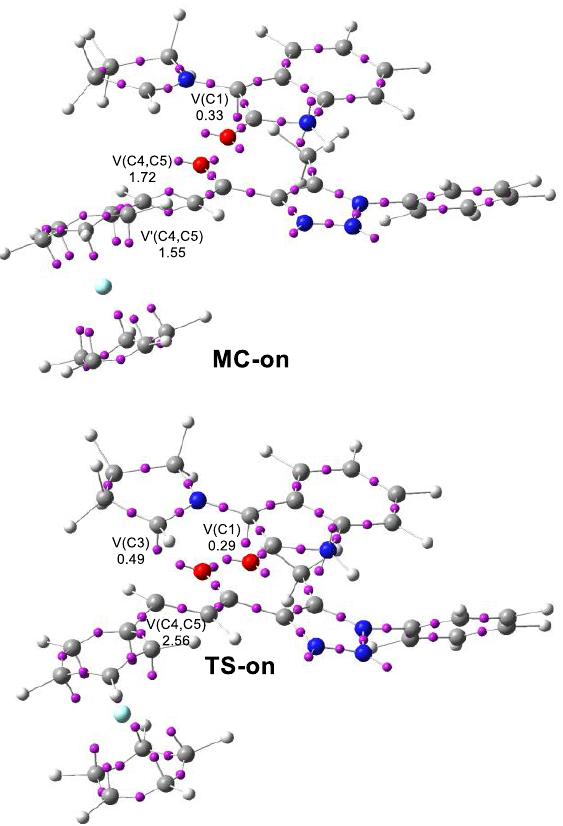
Figure 6. ω B97X-D/6-311G(d,p) ELF basin attractor positions together with the populations of the most relevant valence basins of MC-on and TS-on . Valence basin populations are given in average number of electrons (e).